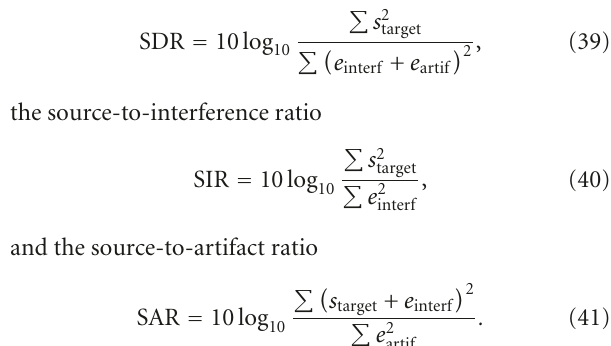
Figure 7: Room setup, room height =